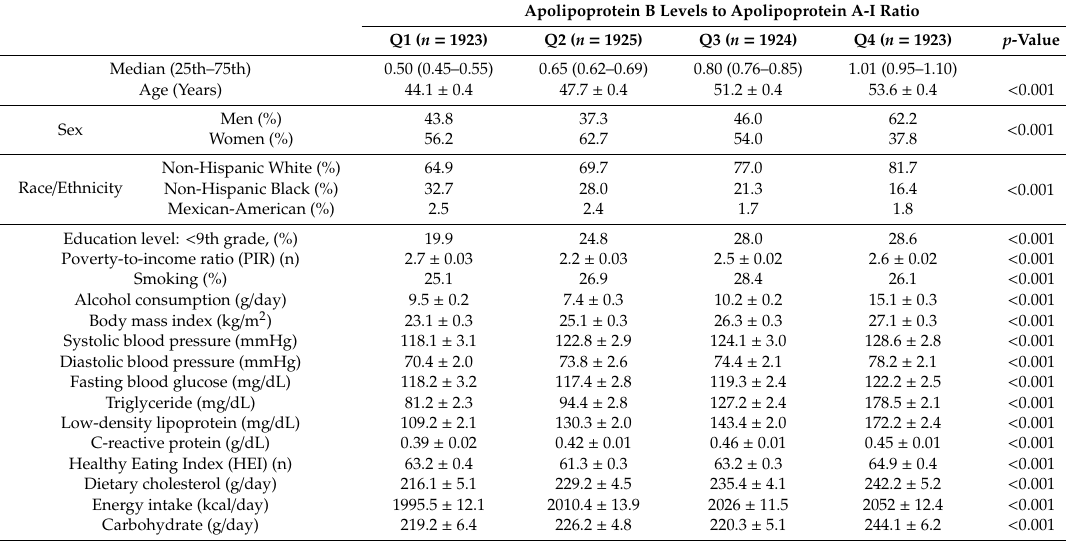
Table 1. Characteristics of the study participants based on apolipoprotein B (apoB) levels to apolipoprotein A-I (apoA-I) ratio (3rd National Health and Nutrition Examination Survey (NHANES III)).